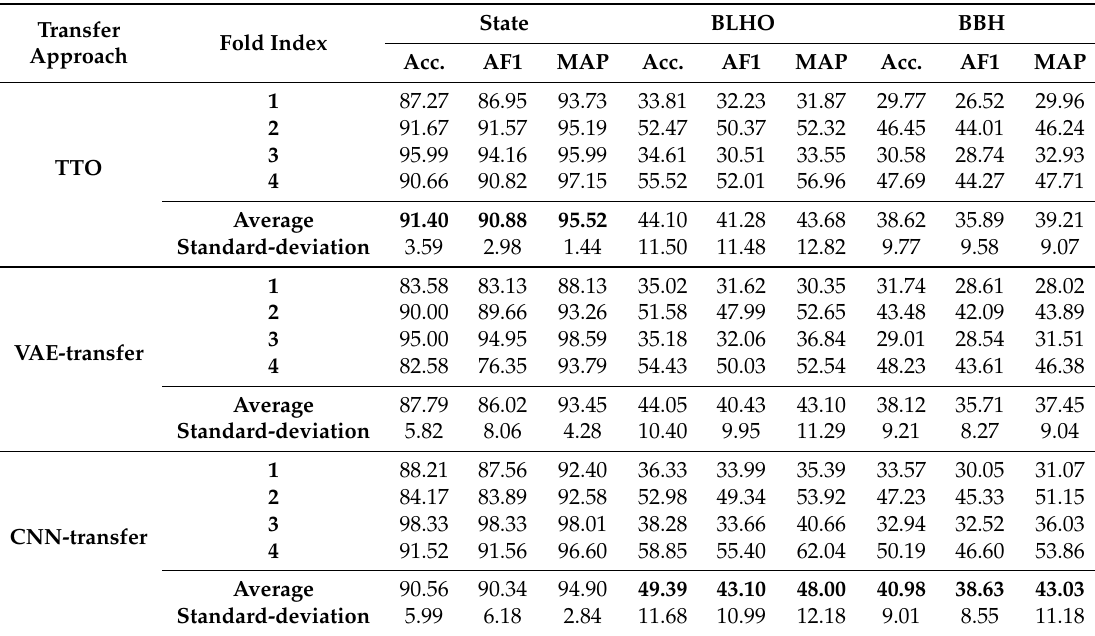
Table 6. Accuracies, Average F1-Scores, and MAPs (in %) obtained by TTO, VAE-transfer, and CNN-transfer for the state, BLHO, and BBH classification problems in the subject-independent configuration (leave-one-subject-out cross-validation). The best average performances for each classification problem and evaluation metric are highlighted in